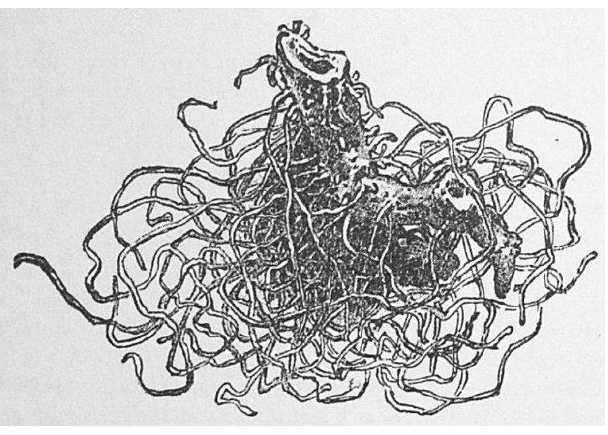
Fig. 4. The rhizome of the medicinal plant Caulophyllum thalictroides (blue cohosh). Image from Lloyd and Lloyd